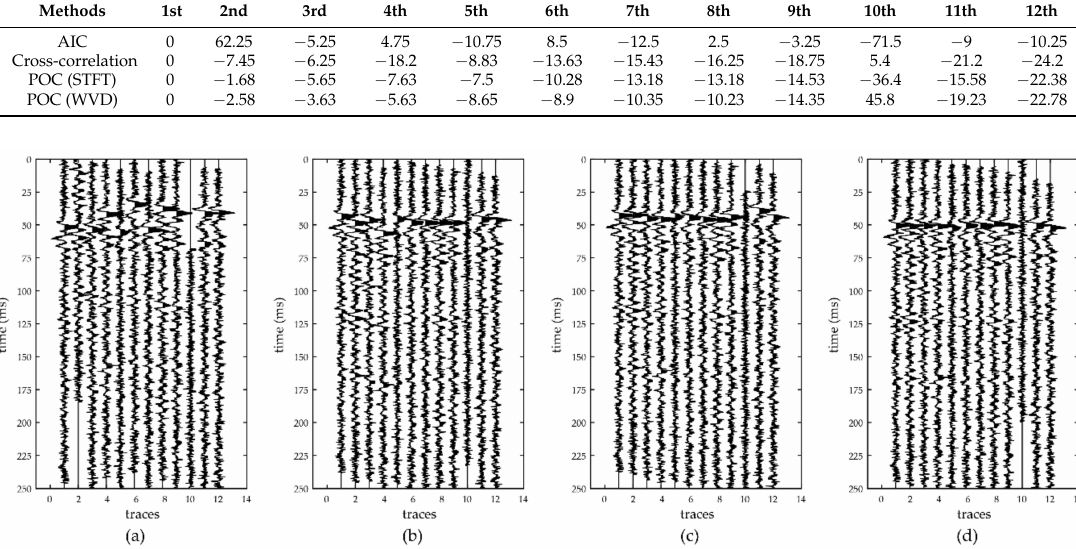
Figure 11. Using estimation values of the relative arrival times to eliminate the arrival time difference among the traces of the second noisy data. ( a ) The result based on AIC; ( b ) the result based on cross-correlation; ( c ) the result based on POC (STFT); ( d ) the result based on POC (WVD).